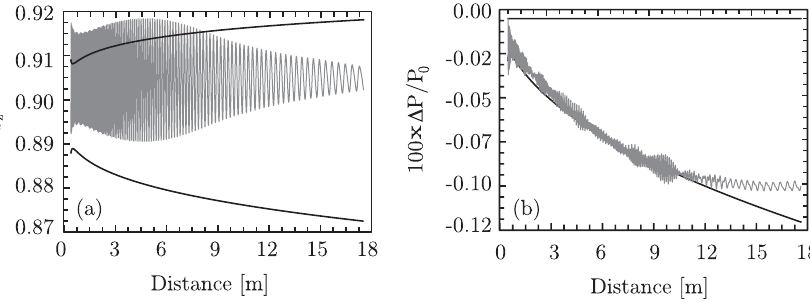
FIG. 7. QUICKPIC simulation results for an externally guided LWFA, using a 800 J laser pulse to accelerate an electron beam with ¼ 62 : 5 mm mrad to 70 GeV. The black curves refer to the predictions of the analytical model, and the gray normalized emittance (cid:8) N for a given beam electron. The results of the model assumed curves represent the simulation results. Part (a) shows the evolution of s z no initial transverse electron momentum. Part (b) shows the evolution of the total polarization. The analytical results illustrate the assuming a zero-emittance electron maximum and minimum values of (cid:3) P=P 0